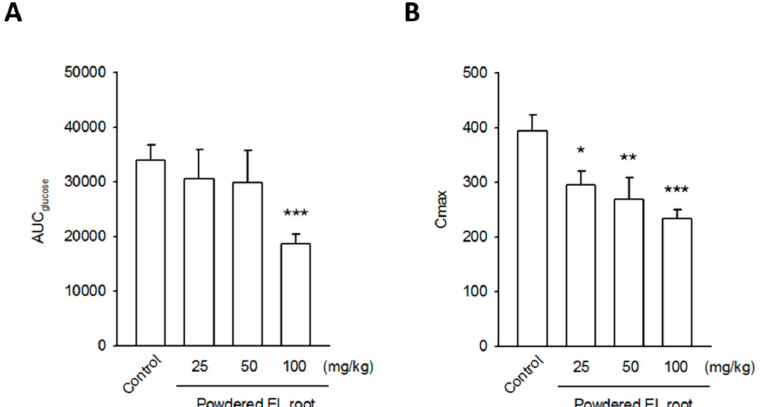
Figure 2. E. longifolia changed the kinetic of glucose absorption in db / db mice. The AUC glucose ( A ) and C max ( B ) were calculated as described. A significant reduction in AUC glucose was observed in the high-dose EL-treated group, whereas the notable decrease in C max was found in all EL-treated groups. (* p < 0.05, ** p < 0.01, *** p < 0.001, indicates a statistically significant difference from the control group).